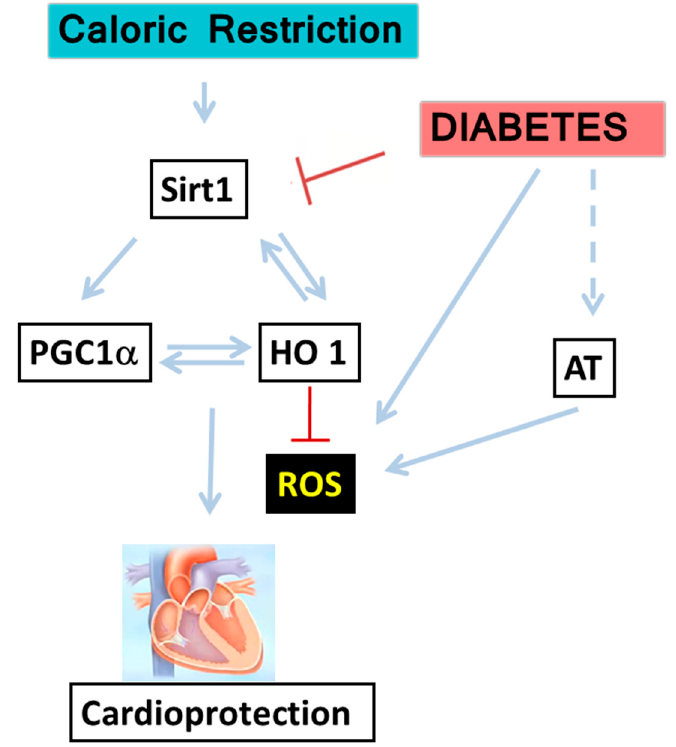
Figure 5. Illustration of CR cellular signaling hereby suggested to participate in the development of Type II diabetic cardiomyopathy: The energetic dysfunction in diabetes increase in the heart together